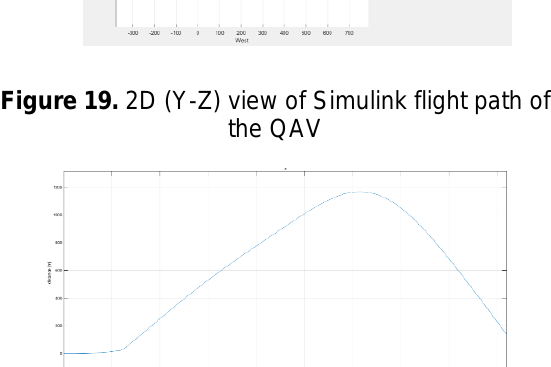
Figure 24. V linear velocity response for the QAV